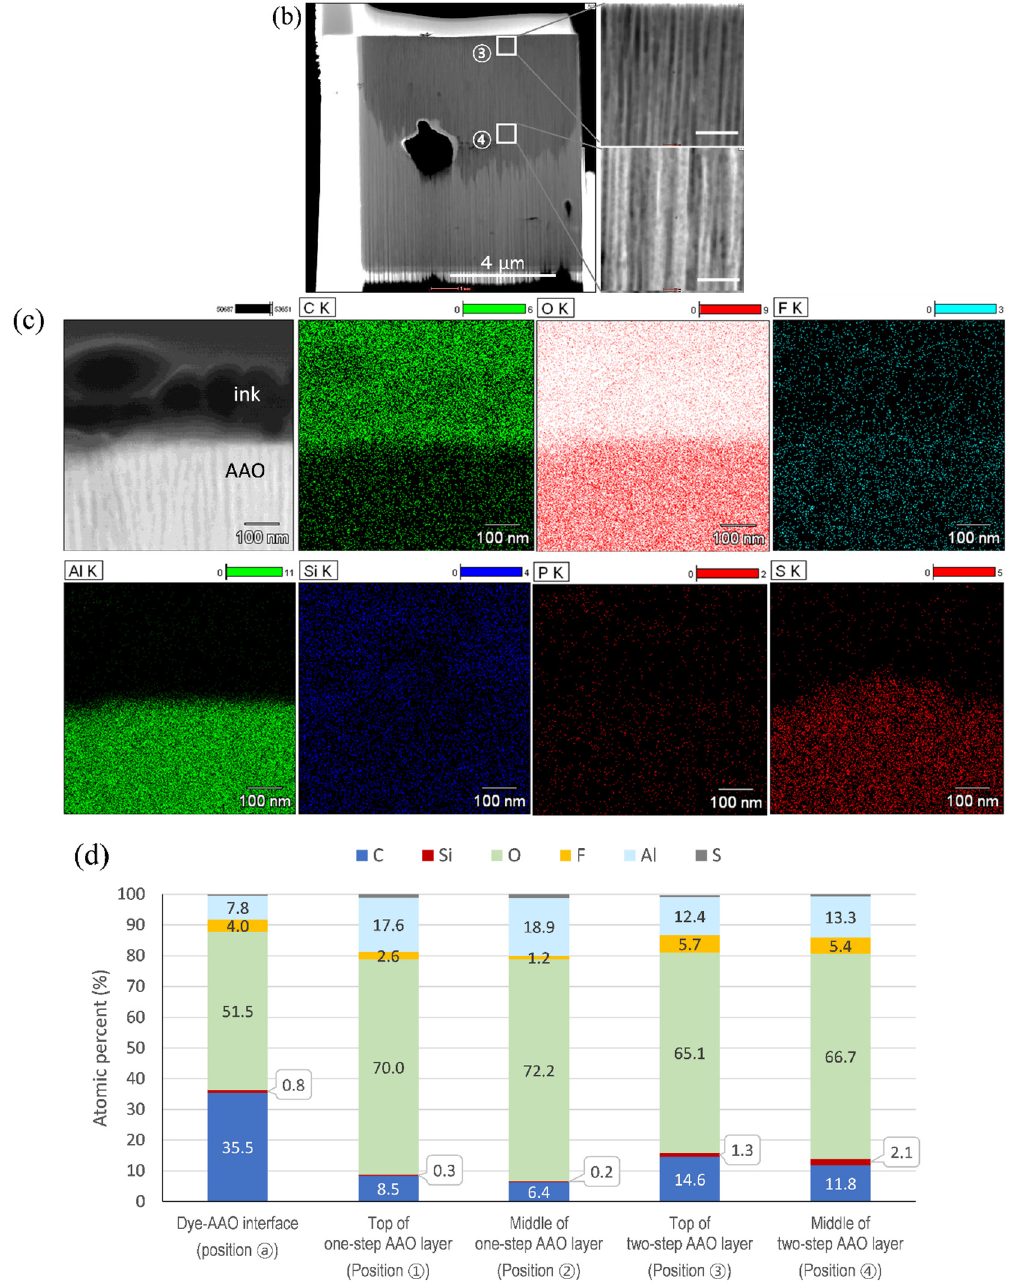
Figure 12. TEM-EDS measurement results for the one-step and two-step AAO layers wetted in solvent-based ink and dried. ( a , b ) SEM images of thinned foil cross-section and TEM images (scale bar 200 nm) of near top surface and middle positions in the oxide film for the one-step and two-step AAO layer, ( c ) EDS elemental maps of the interface with the deposited dye residue on the one-step AAO layer ( a (cid:13) in ( a )), and ( d ) comparison of elements composition at different positions ( a (cid:13) , 1 (cid:13) – 4 (cid:13)